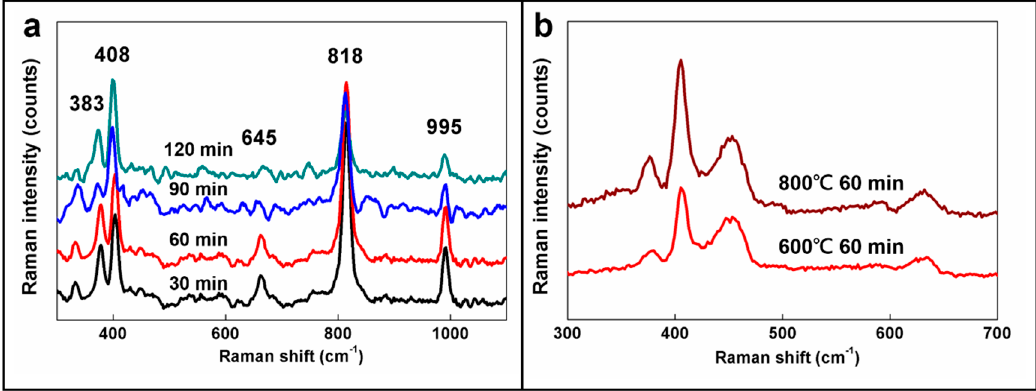
Figure 1. Raman analysis for IF-MoS 2 nanoparticles (NPs) ( a ) for different sulfidation times at 600 °C and ( b ) at different sulfidation temperatures for 60 min.